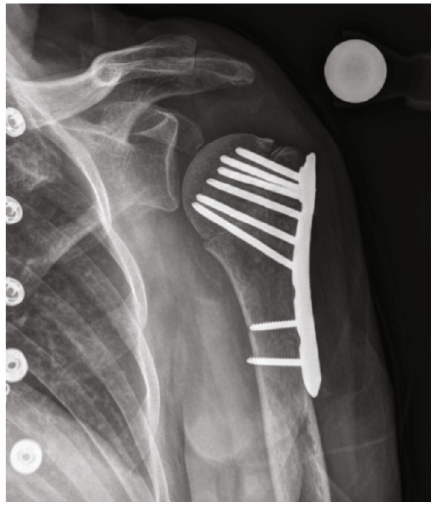
Figure 2: Left proximal humerus fracture following open reduction and internal fi xation. A plain radiograph of the left shoulder taken in the anteroposterior (AP) direction six weeks after surgery. There is no displacement of the fracture fragments and reduction is